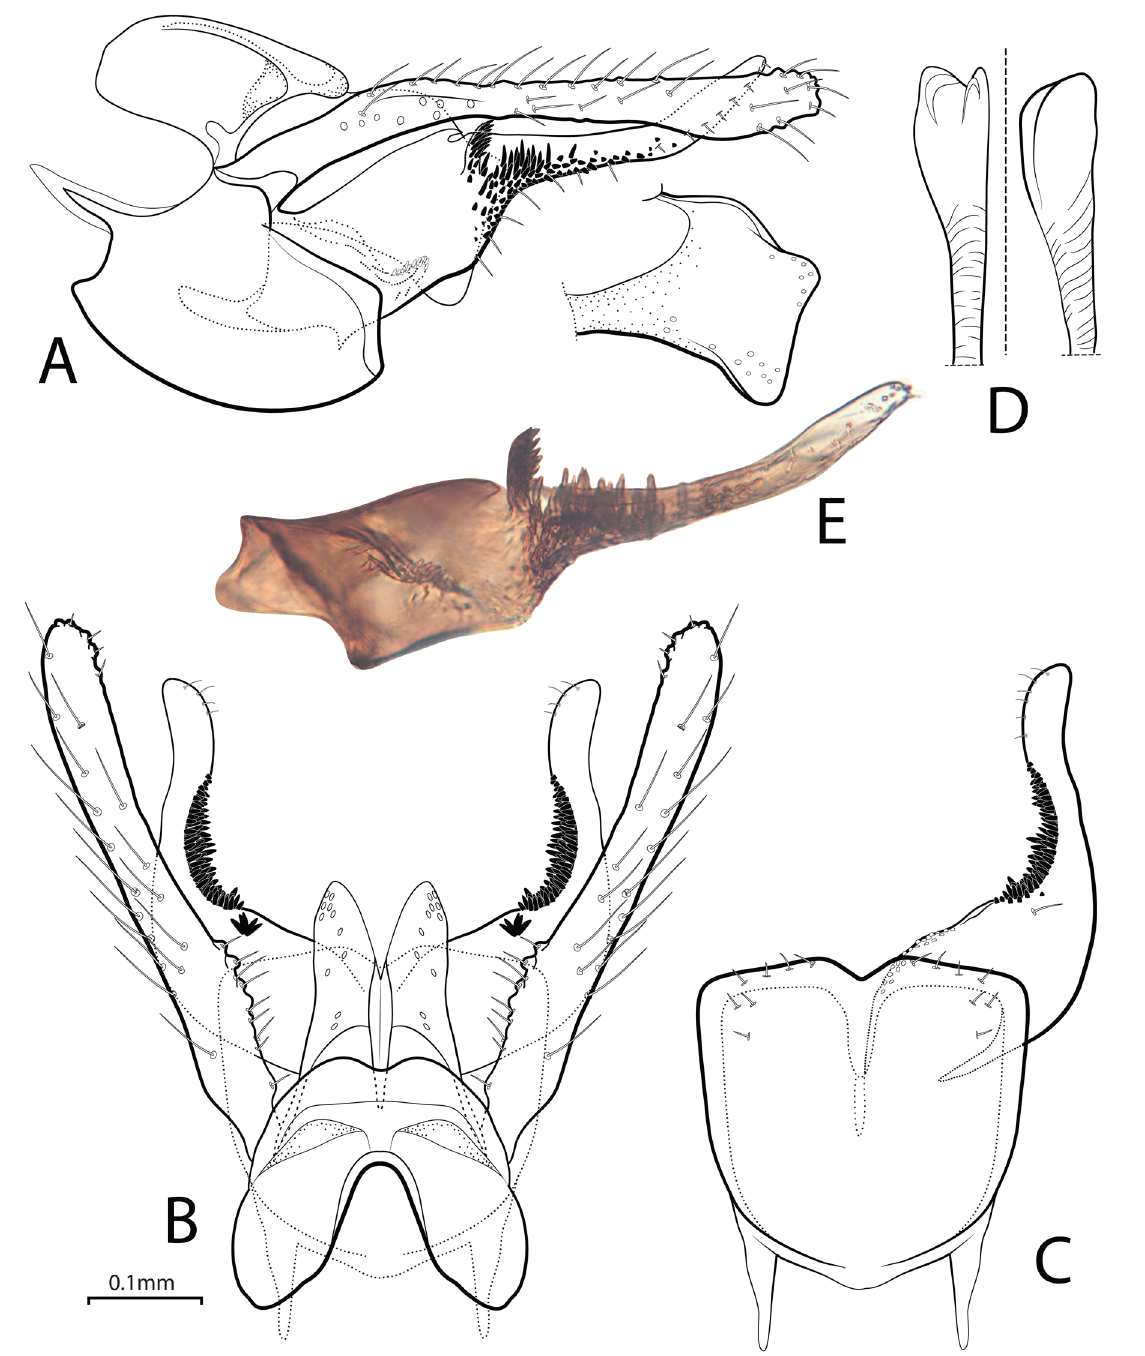
Fig. 6. Xiphocentron harakbut sp. nov.,holotype, male genitalia (MUSM-ENT-0320564). A . Lateral view, with detail of paraproct. B . Dorsal view. C . Ventral view. D . Phallus, dorsal and lateral views, respectively. E . Left inferior appendage, photograph, lateroventral